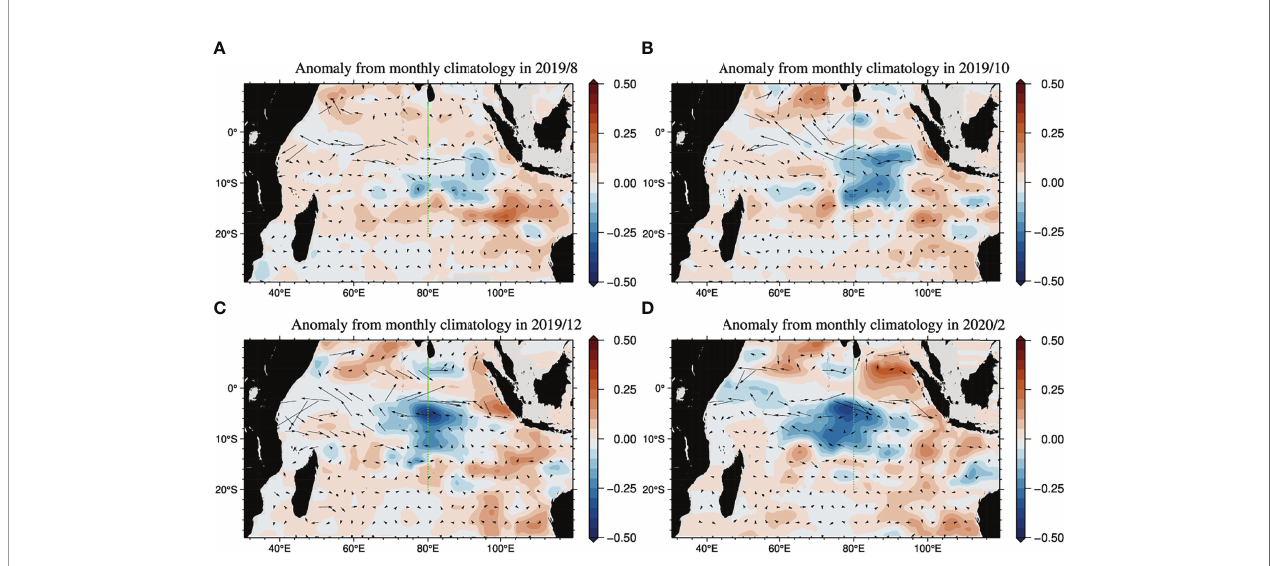
FIGURE 6 | Salinity anomalies in August 2019 (A) , October 2019 (B) , December 2019 (C) , and February 2020 (D) from the climatological mean (2006 – 2020) at 25.0 g based on the Argo gridded dataset. The black arrows show the geostrophic velocities at 25.0 g . The green dots show the stations along the I08N line in